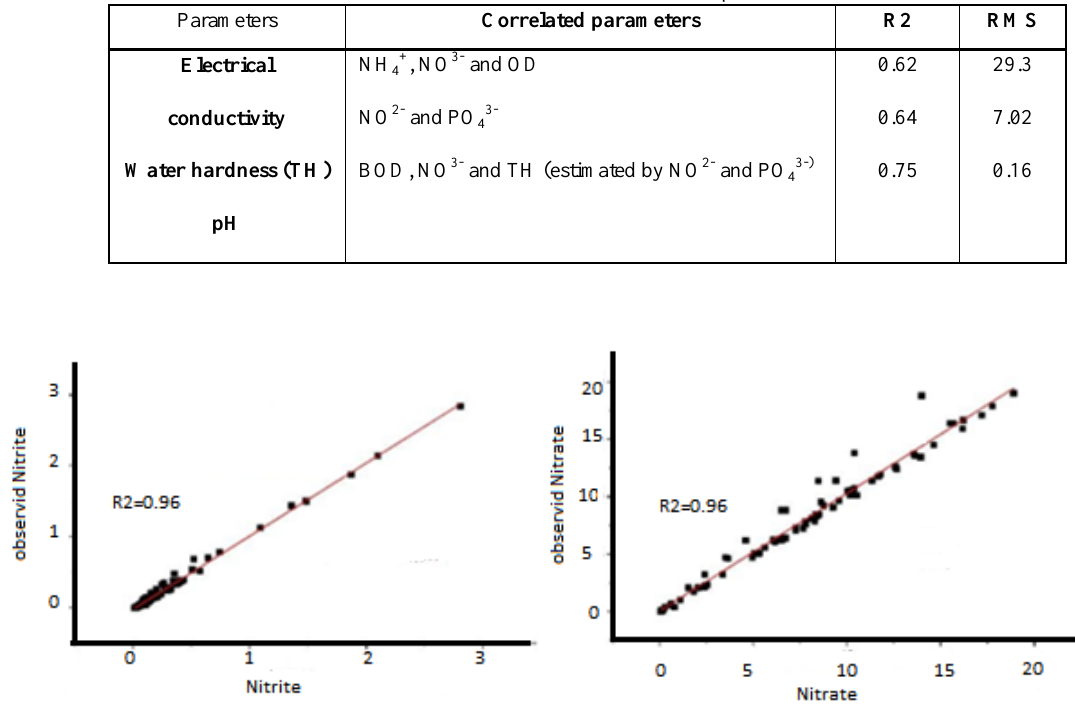
Figure 5: Corrélation entre Ni2- ,Ni3- simulés et